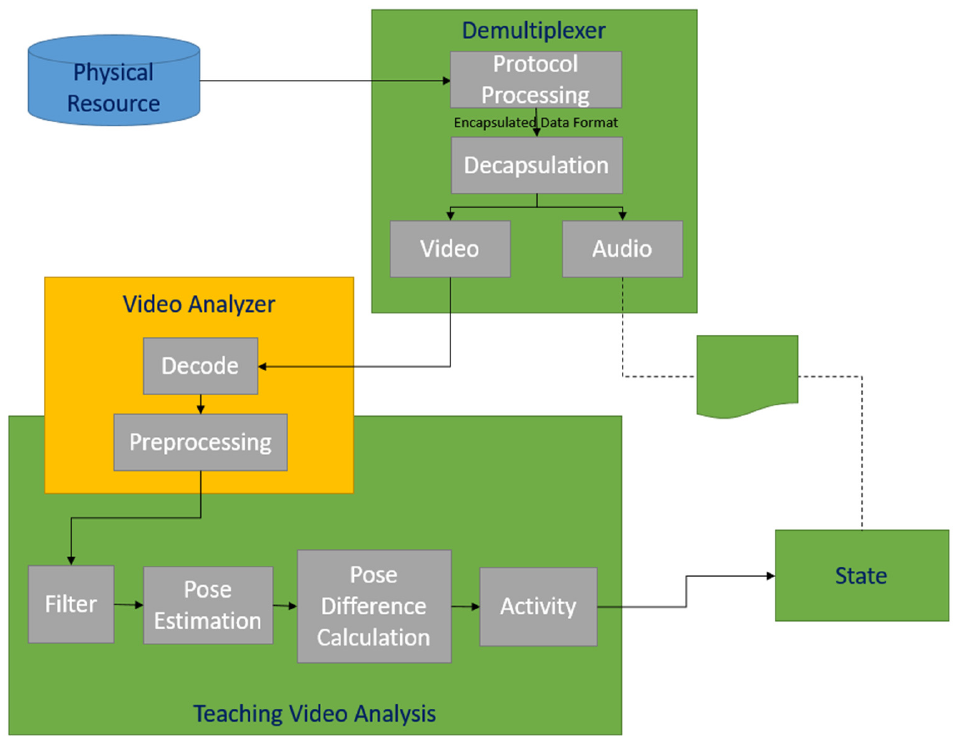
Figure 1. Teaching video analysis flowchart.